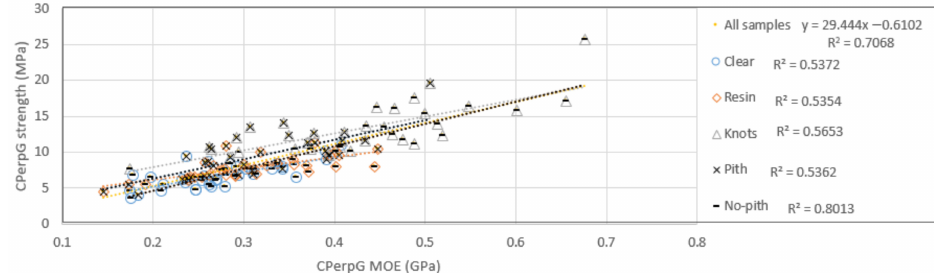
Figure 22. Relationship of CPerpG MOE and strength.